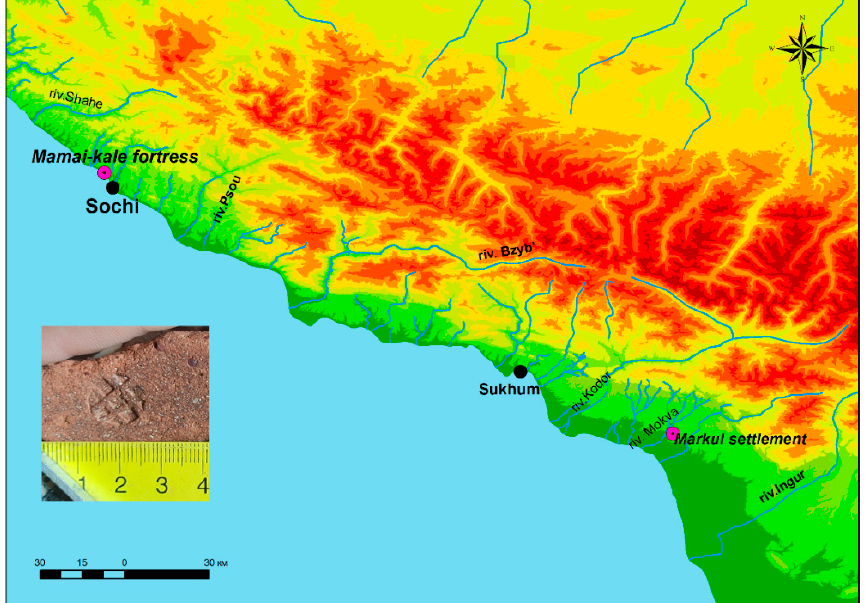
Figure 7. The stamp on the pithoi in the form of a meshed circle and the places where they were found marked on the map.